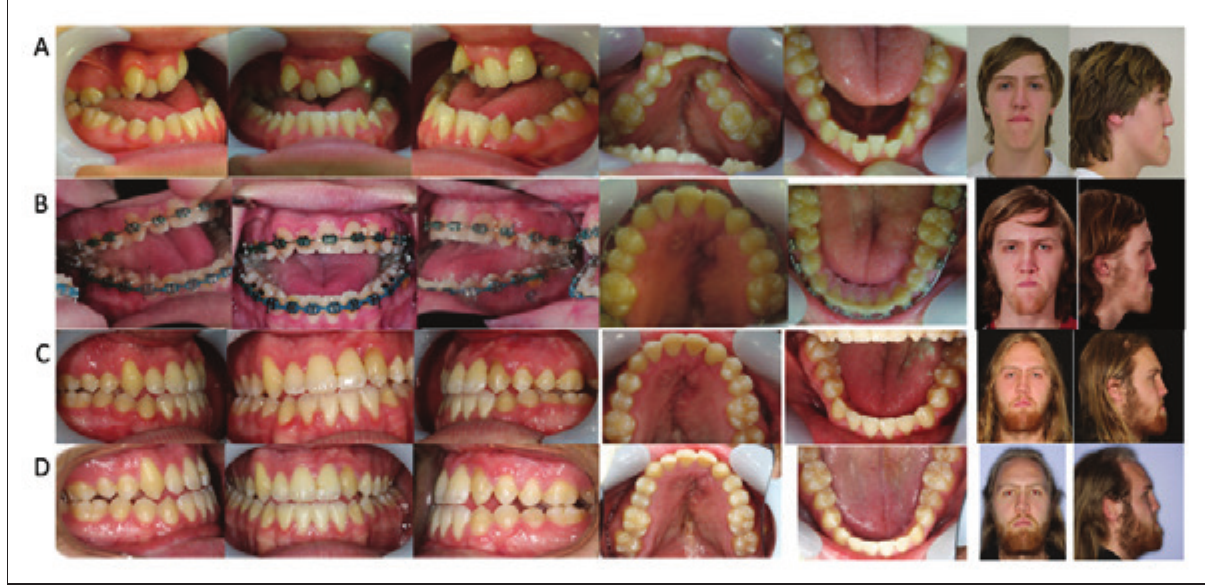
Figure 1. Intraoral and extra-oral clinical photographs (A) Pre-orthognathic orthodontic preparation (B) Pre-distraction placement (C) Orthodontic appliance removal four months post-surgery (D) 2.4 year